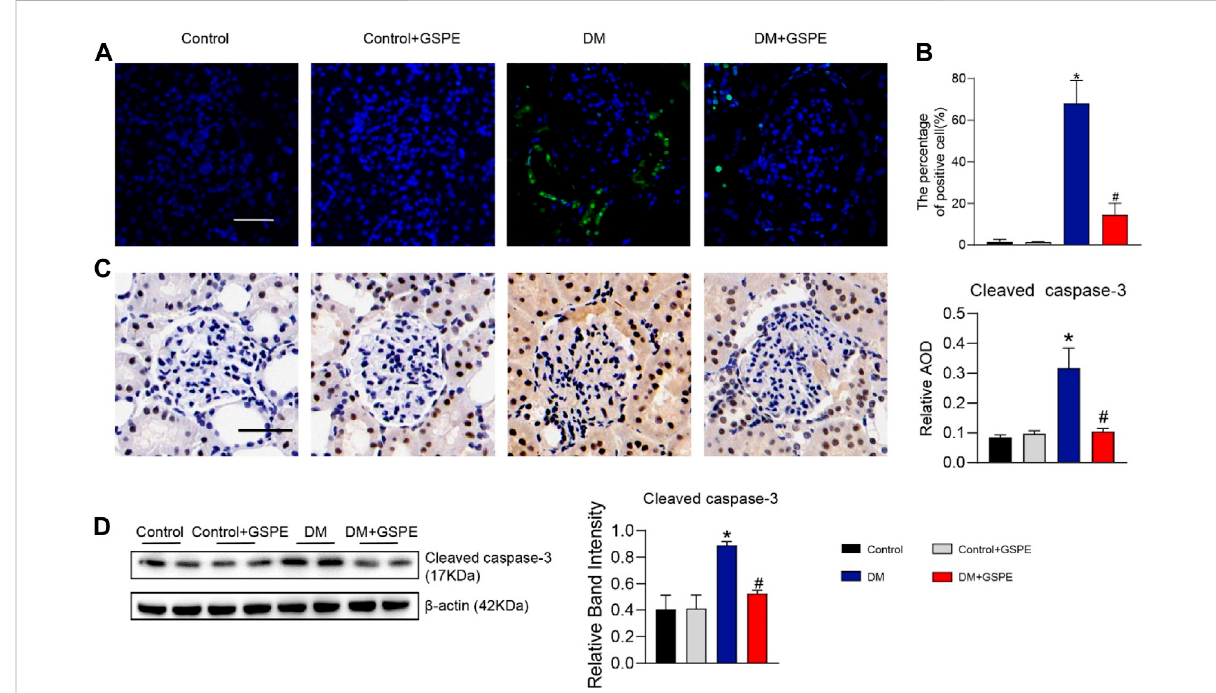
FIGURE 4 (A) Theimagesofcellapoptosisofratrenaltissue.Scalebars,50 μ m. (B) Evaluationofapoptosisrateinrenaltissueofratsineachgroup.Mean± SD. n = 6. p p < 0.05 vs. control; # p < 0.05 vs. DM group. (C) Immunohistochemistry delineated the localization and changes in the expression of Cleavedcaspase-3proteinsandquanti fi cationofrelativeAODineachgroup.(Scalebars,50 μ mOriginalmagni fi cation,×200)Mean±SD.n=6. p p